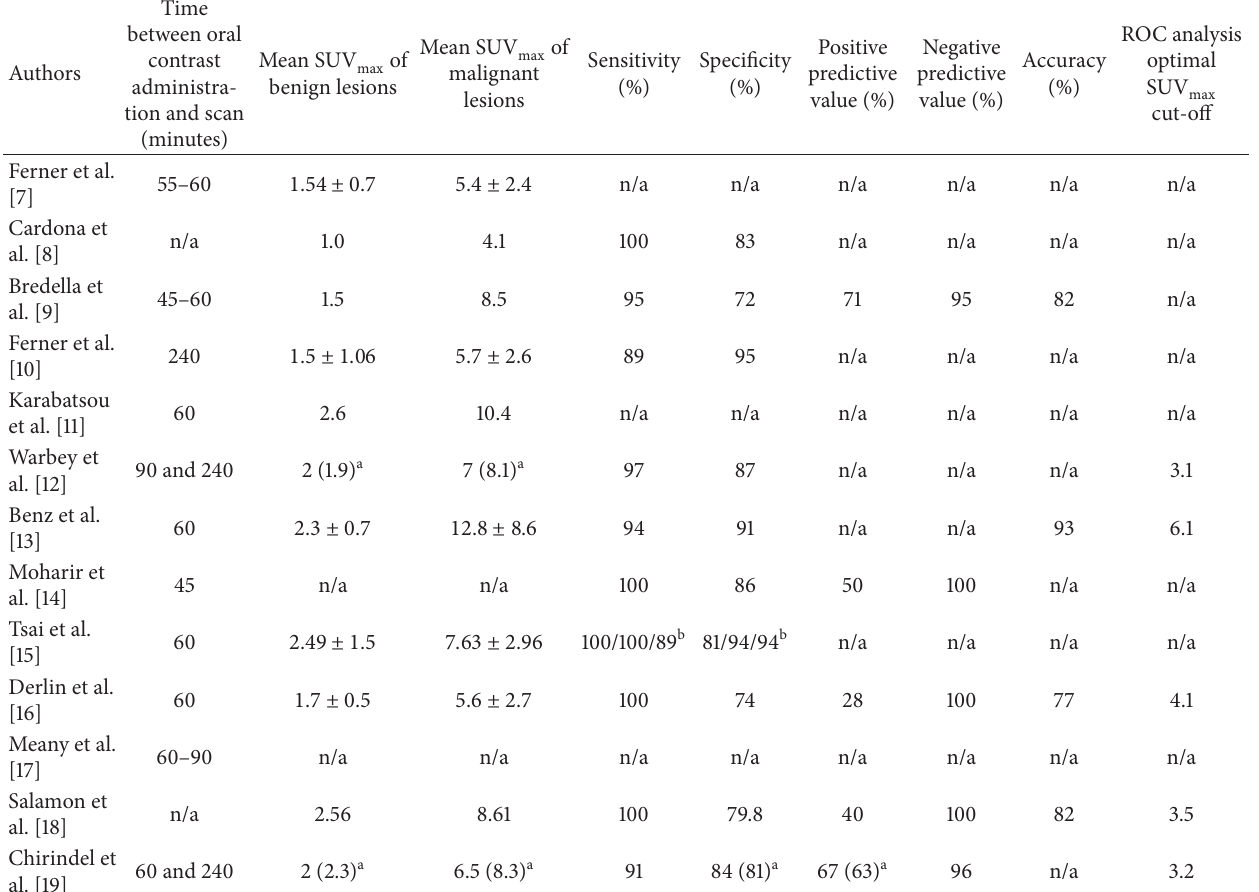
Table 2: Characteristics of the FDG-PET/CT